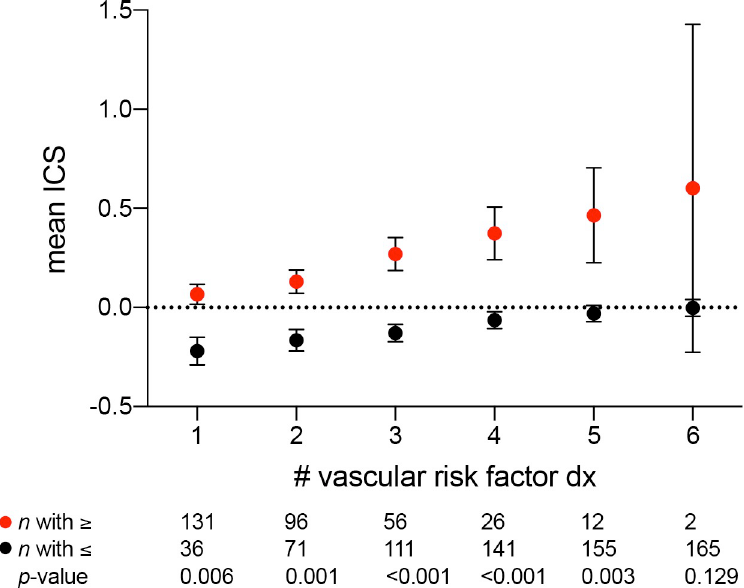
Fig 5. ICS increases with vascular risk factors. Mean ICS in groups with one or more vascular risk factor diagnoses (red) vs. those with less vascular risk factor diagnoses (black). All group comparisons were statistically significant at adjusted p < 0.008 except between those with 6 vascular risk factor diagnoses ( n = 2).